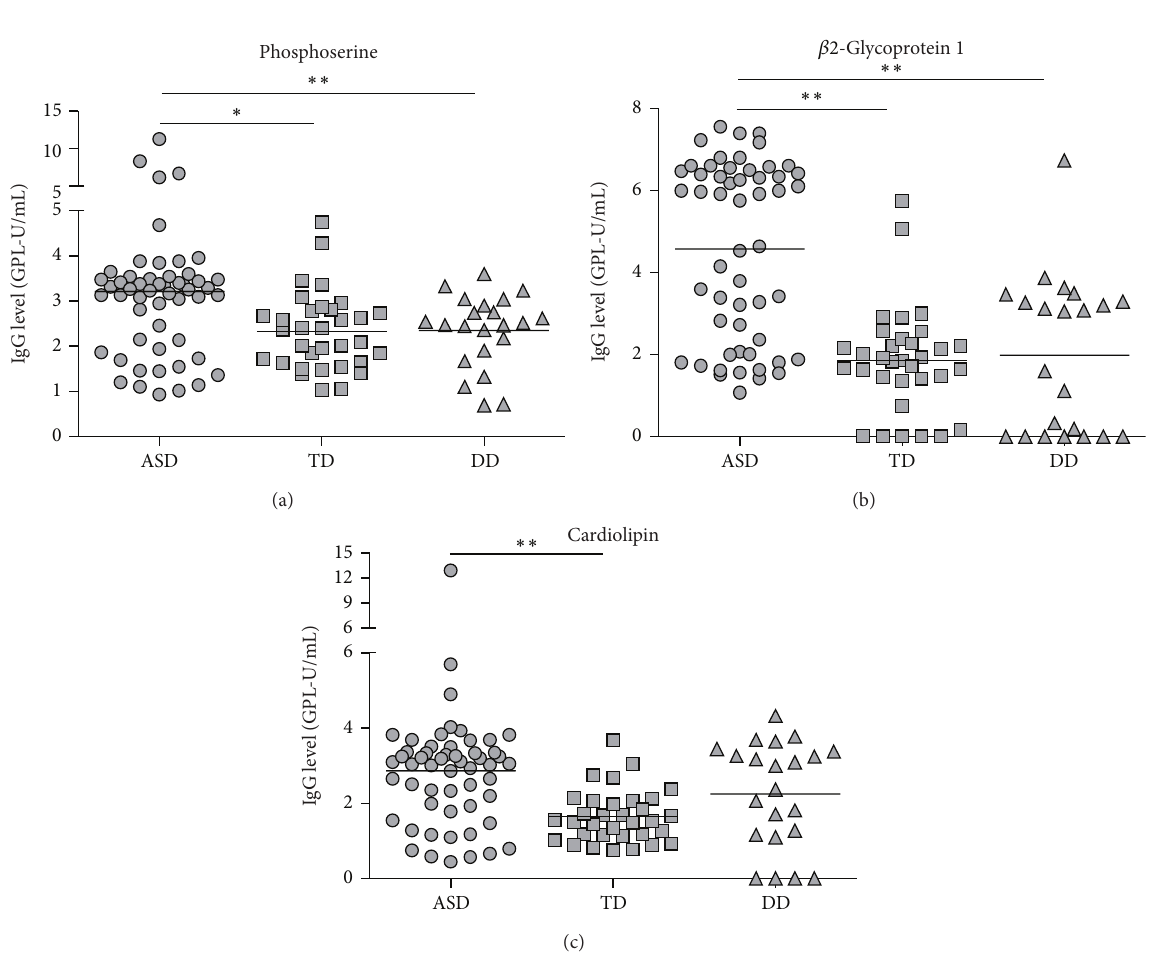
Figure 1: Anti-phospholipid antibody levels. (a) ASD subjects were found to have significant ( 𝑃 < 0.01 ) levels of anti-phosphoserine and (b) anti- 𝛽 2-glycoprotein 1 antibodies compared with TD and DD controls. Levels of (c) anti-cardiolipin were found to be significantly ( 𝑃 < 0.001 ) higher in ASD compared with TD control, but differences to DD control did not reach significance. ∗ 𝑃 < 0.01 , and ∗∗ 𝑃 < 0.001